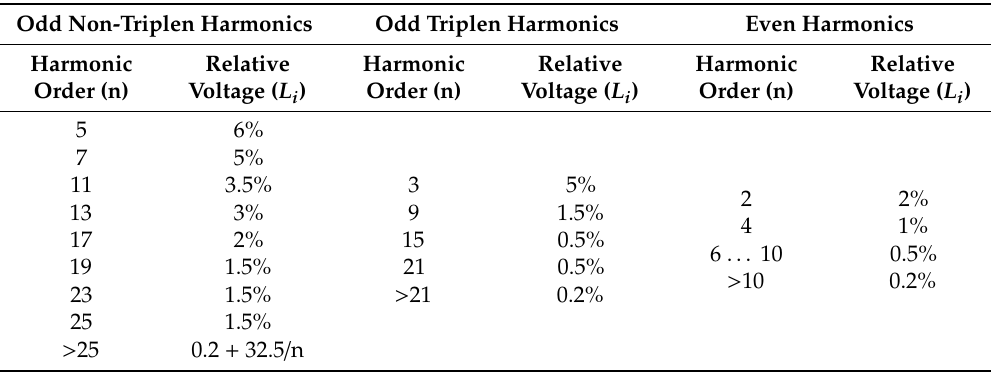
Table 1. Grid codes EN 50160 and CIGRE WG